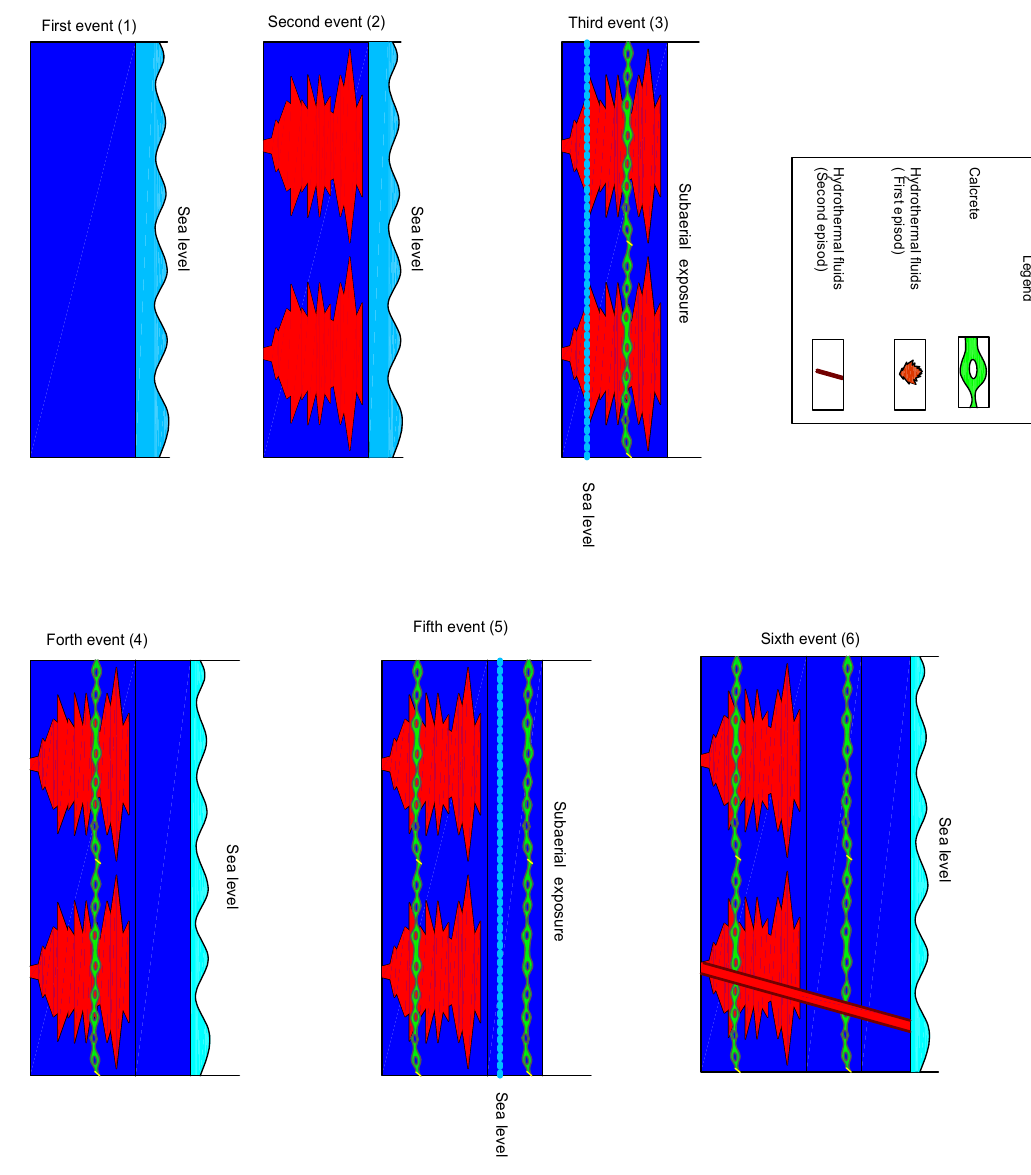
Figure 15. Block diagram illustrating the injection of hydrothermal fluids and calcretization influences in the Spelek–Sulauk area. Hydrothermal fluids followed the strike–slip fault to migrate along the fractures and weakness zones. Biogenic features penetrated hydrothermal products and entrained into Bekhme Formation. This model gives a detailed description of the paragenetic sequence of the area.